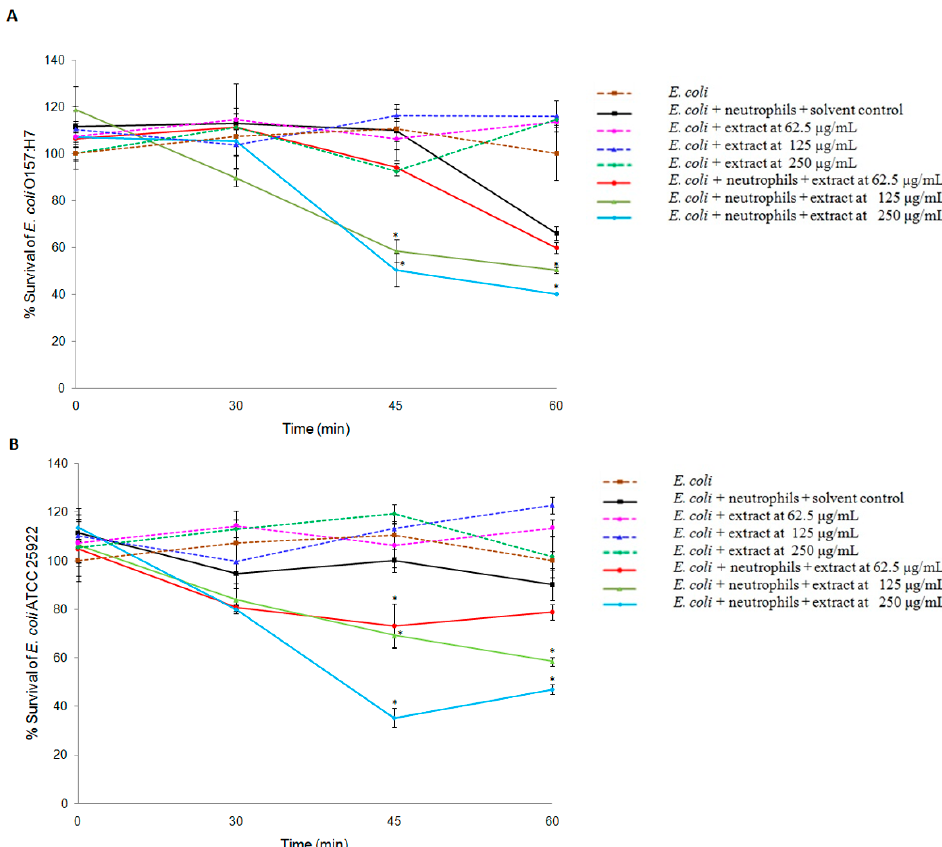
Figure 1. Effects of R. tomentosa extract on the killing activity of human neutrophils against Escherichia coli O157:H7 RIMD 05091078 ( A ) and E. coli ATCC 25922 ( B ). The bacterial cells were exposed to neutrophils in the absence and presence of R. tomentosa extract (62.5–250 µg/mL). Escherichia coli cells in the presence of the extract (62.5–250 µ g/mL) alone were also maintained. Dimethyl sulfoxide (0.5% v / v ) was used as solvent control. The percentage survival of the organisms was determined at 0, 30, 45, and 60 min. Data are expressed as mean ˘ standard error of the mean from two independent experiments. Each measure was performed in triplicate. * Statistical significance at p <